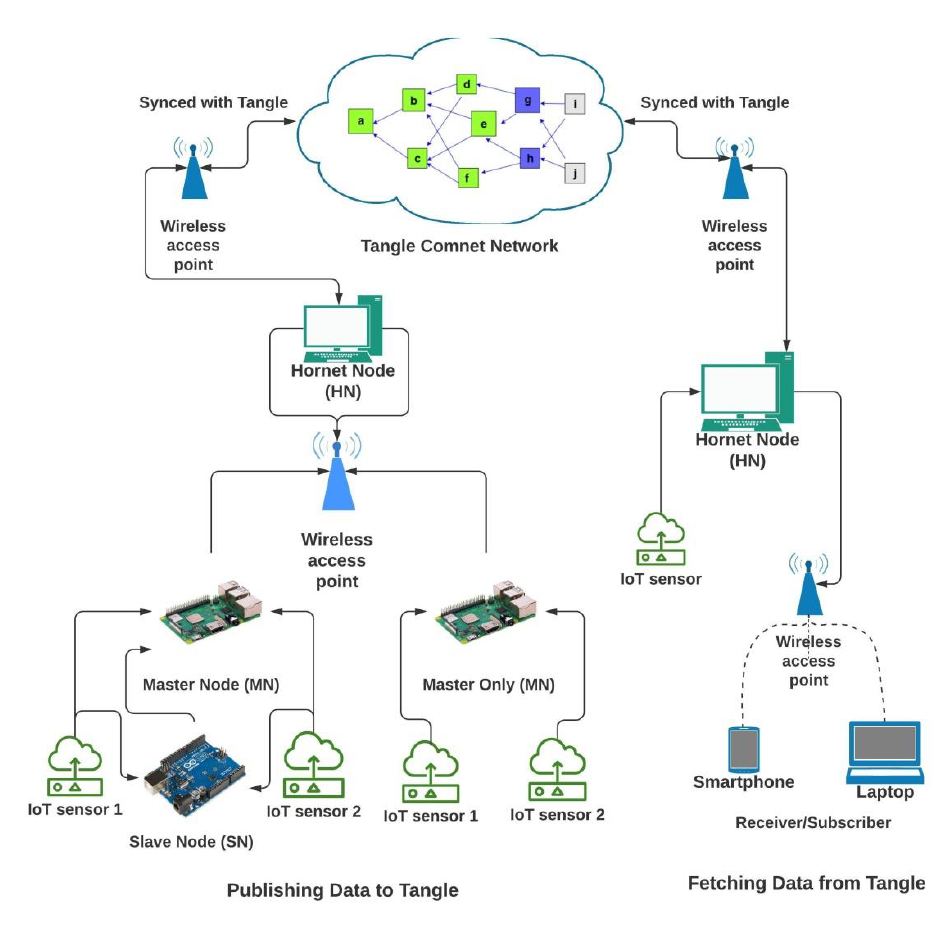
Figure 8. Setup of Hardware infrastructure. Table 3. System and software specification.